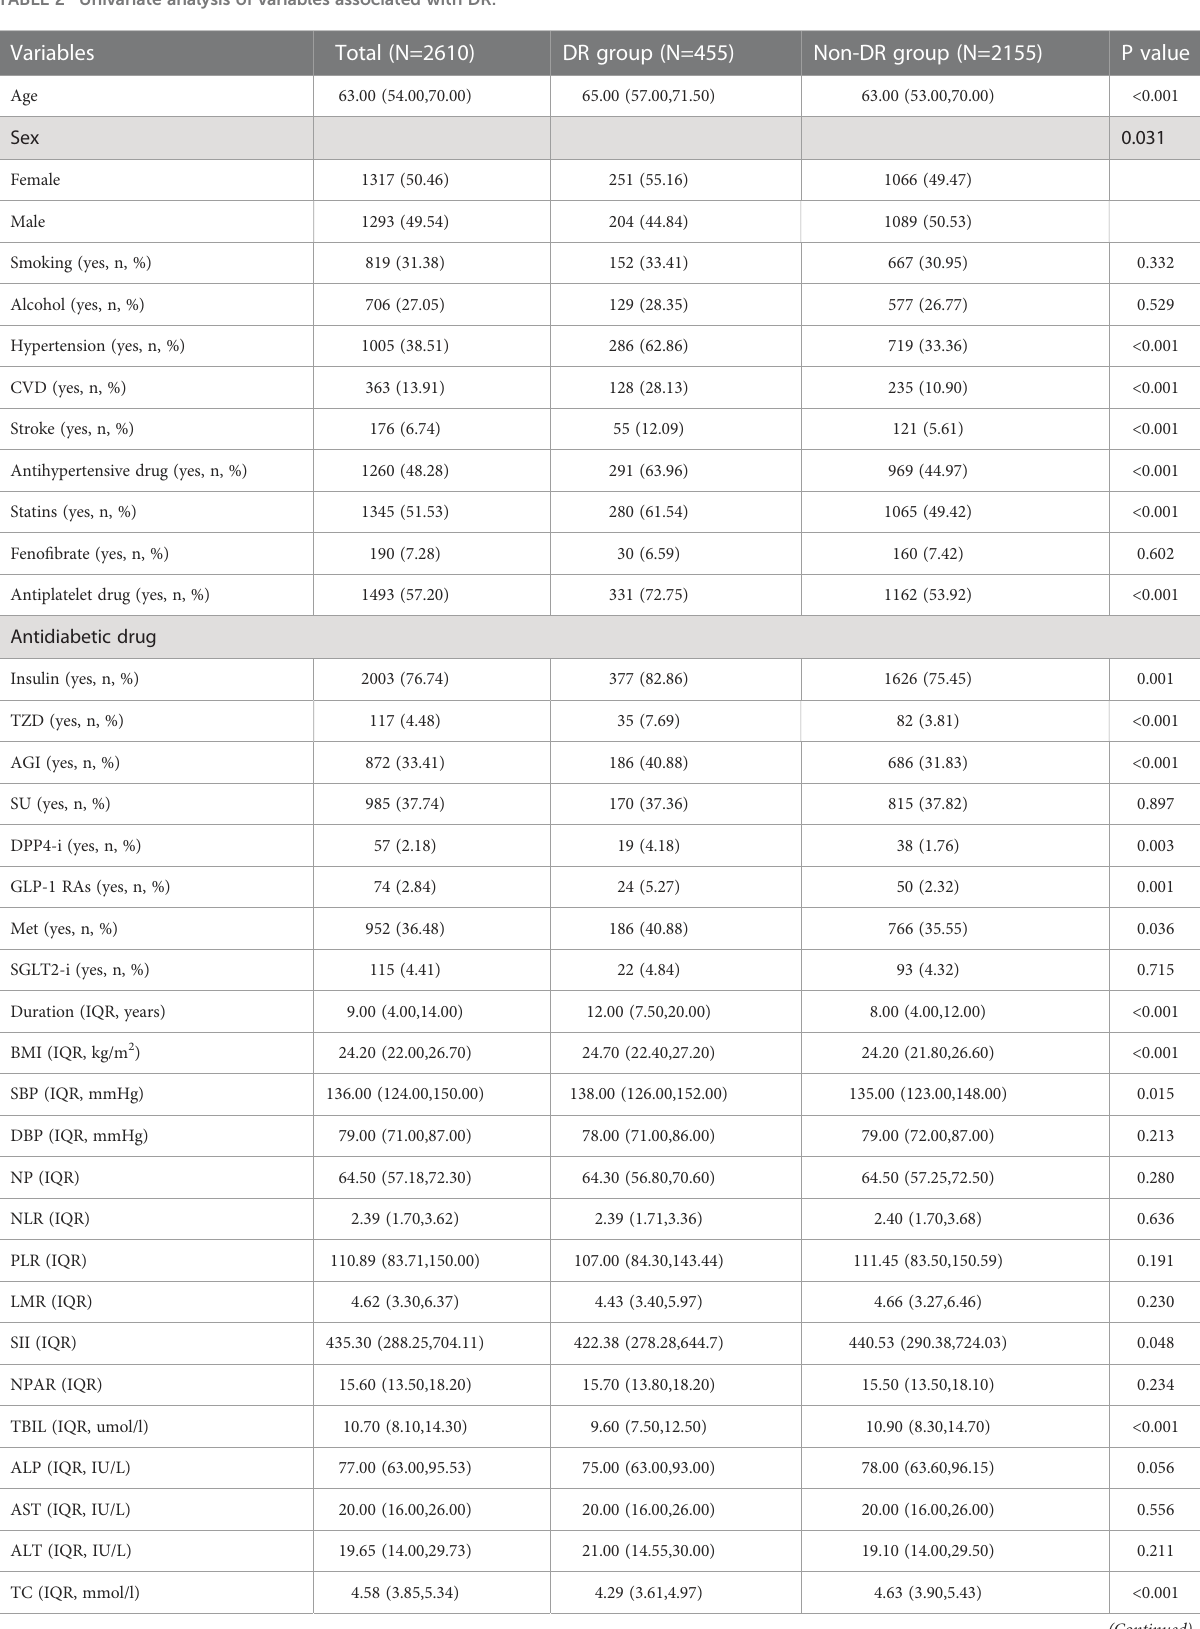
TABLE 2 Univariate analysis of variables associated with